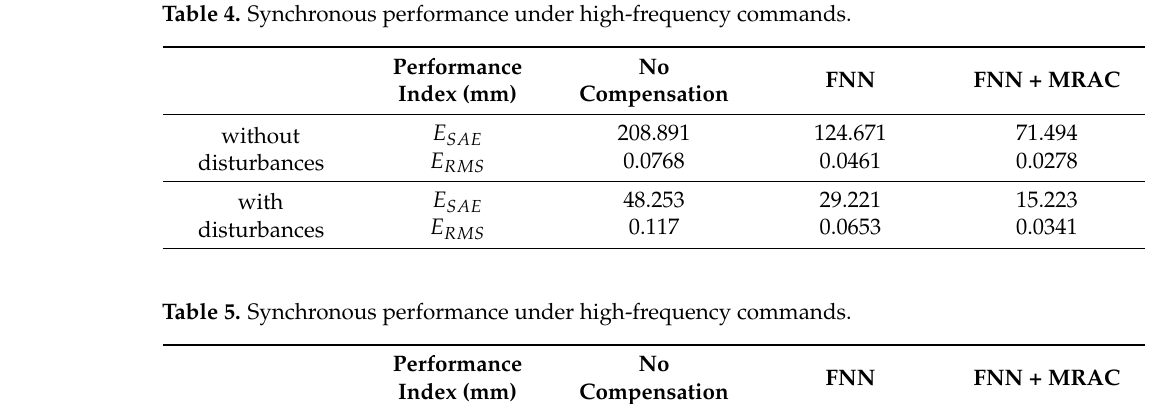
Figure 17. ( a ) The synchronous error under low-frequency commands with disturbances; ( b ) the synchronous error under high-frequency commands with disturbances.